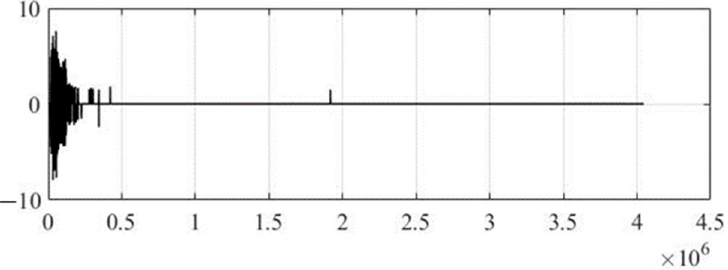
Figure 9. Wavelet coefficients of compressed steganocoded audio signal by 30 times (existing method).